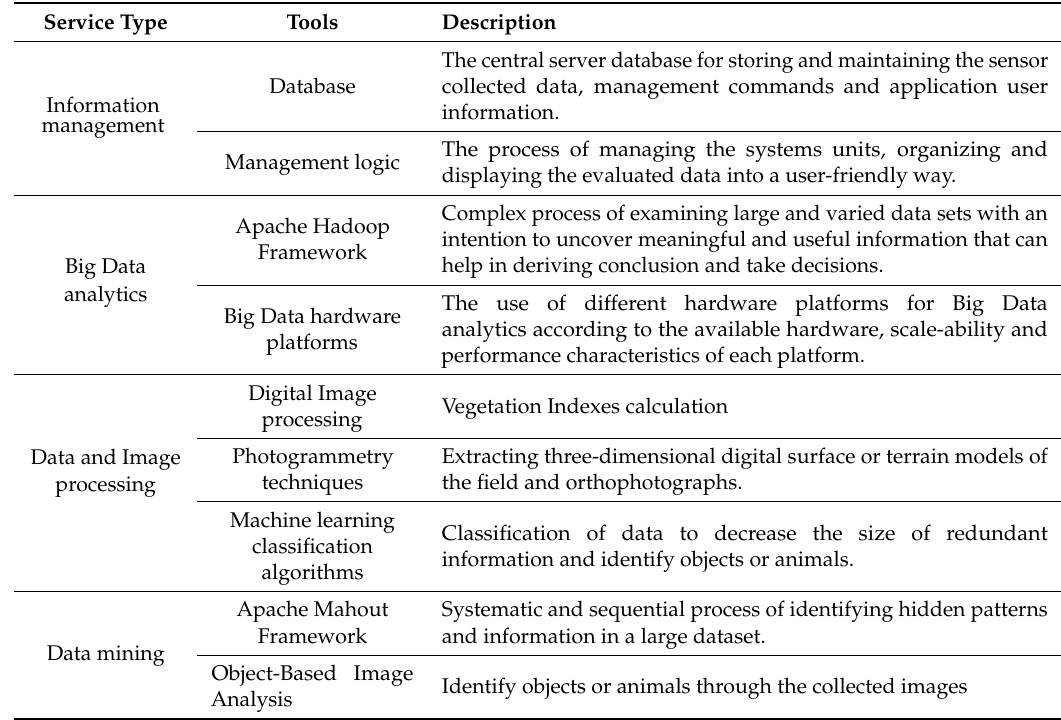
Table 5. Smart farming monitoring system